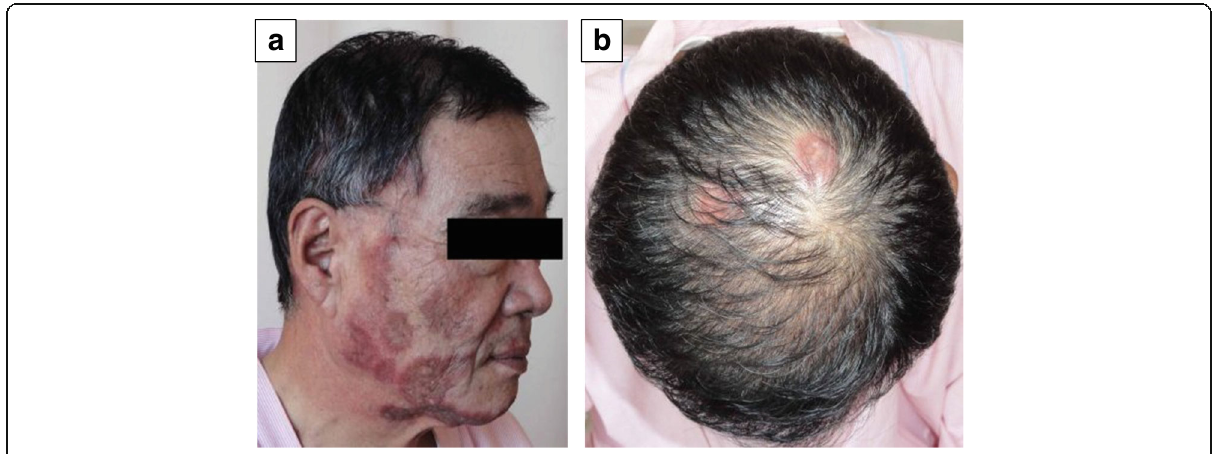
Fig. 4 Erythematous lesions on the face ( a ) and scalp ( b )